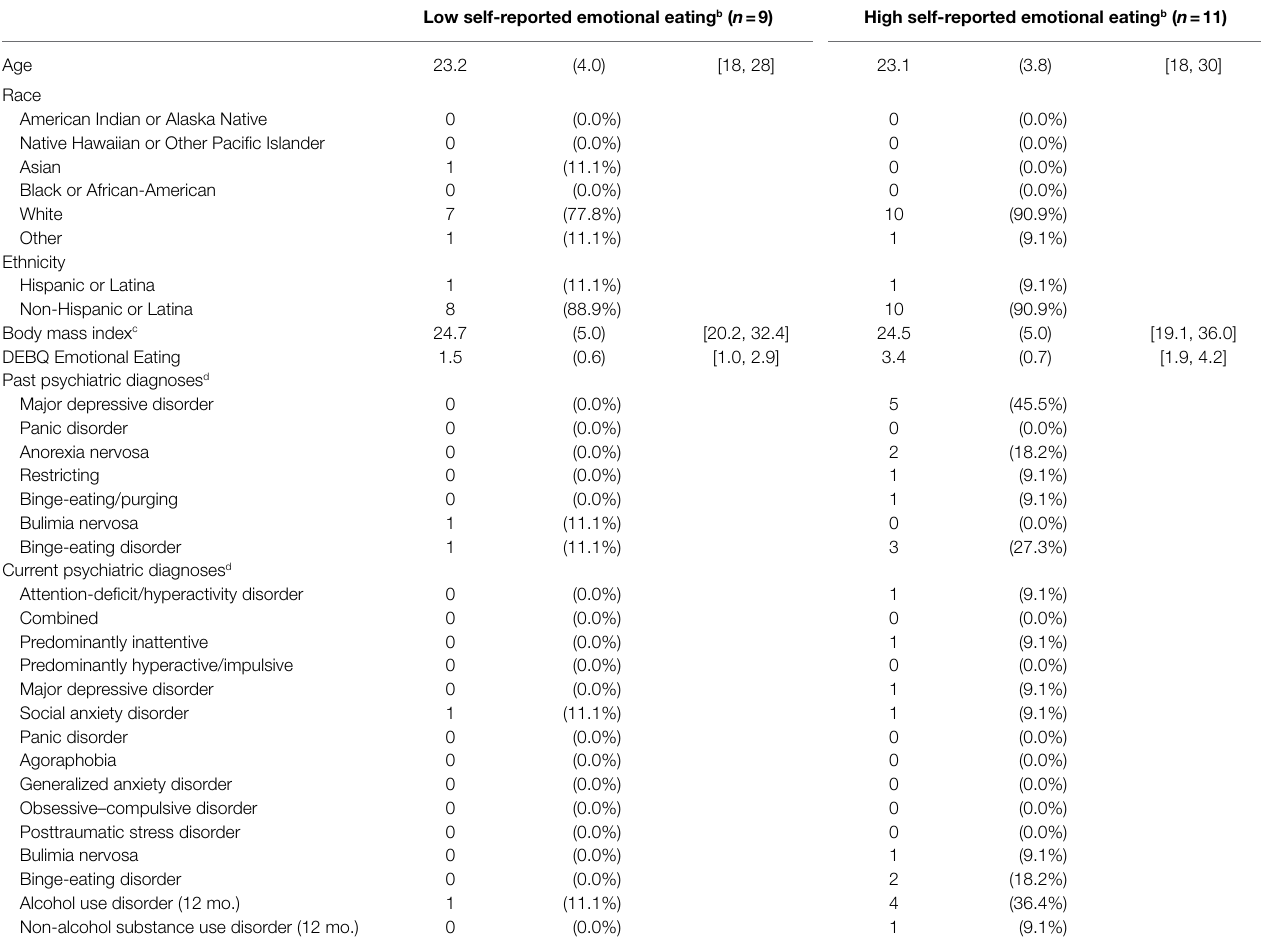
TABLE 1 | Demographic and other information for participants.